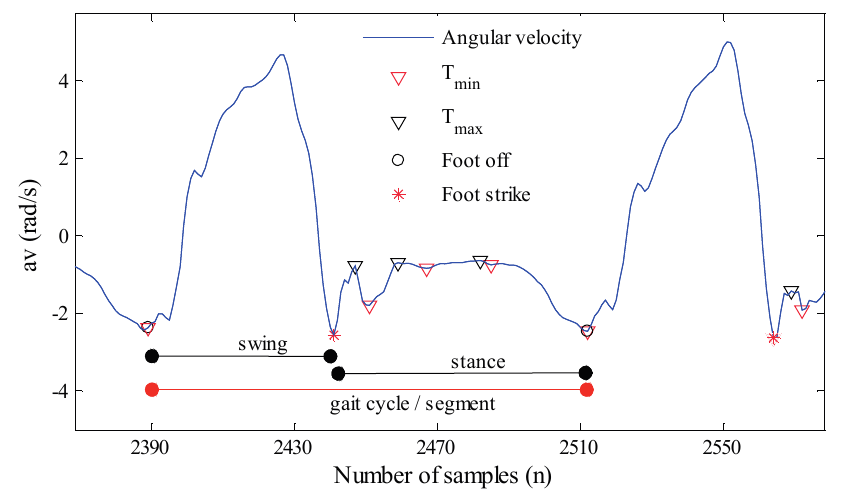
Figure 3. Segmentation algorithm detection for a walking step, where black and red triangles are t max and t min , red asterisks are foot strike and black circles are foot-off